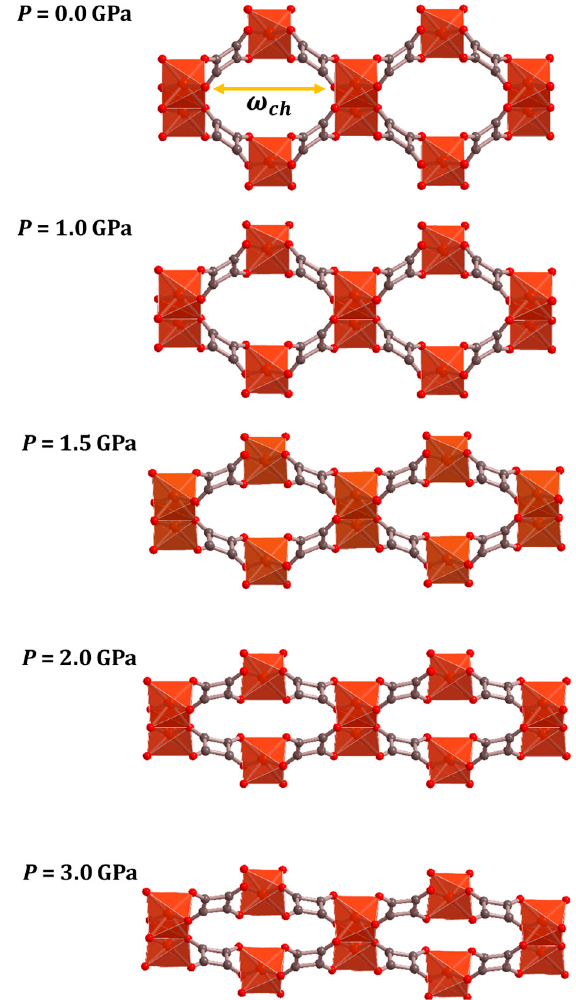
Figure 7. The structure of copper squarate under increasing isotropic pressures. View of a 2 × 1 × 1 supercell from [0 0 1] direction showing two structural channels at different pressures: P = 0.0, 1.0, 1.5, 2.0 and 3.0 GPa. The meaning of the width of a channel ( ω ch ) as measured by the distance between two opposite oxygen atoms is illustrated in the structure at P = 0.0 GPa. The values of ω ch are 8.154, 8.300, 8.810, 9.193 and 9.277 Å , respectively.